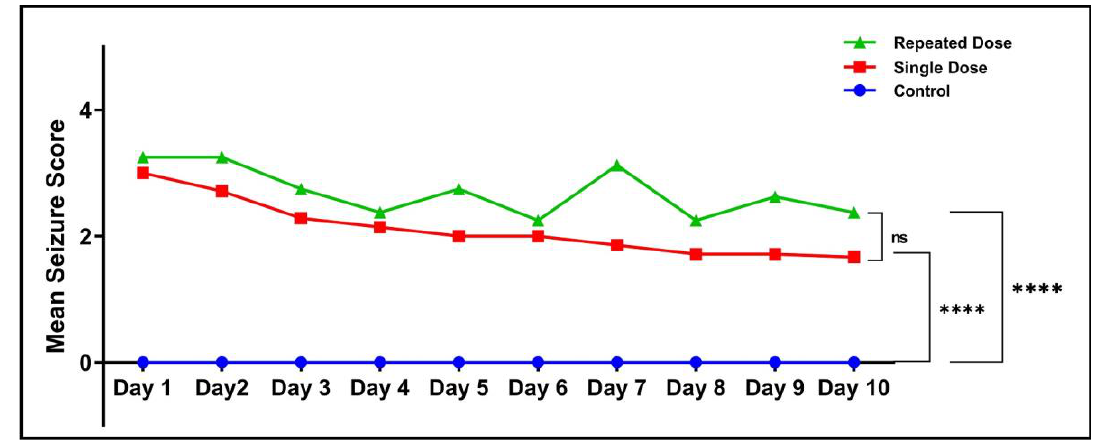
Figure 3. Comparison of mean seizure score. All the values were expressed as mean ± SEM and each data point where the average of 10 fish in each group ( n = 10). Statistical analysis was carried out using two-way ANOVA, p < 0.05 was considered significant * p < 0.05, ** p < 0.01, *** p < 0.001, **** p < 0.0001 .